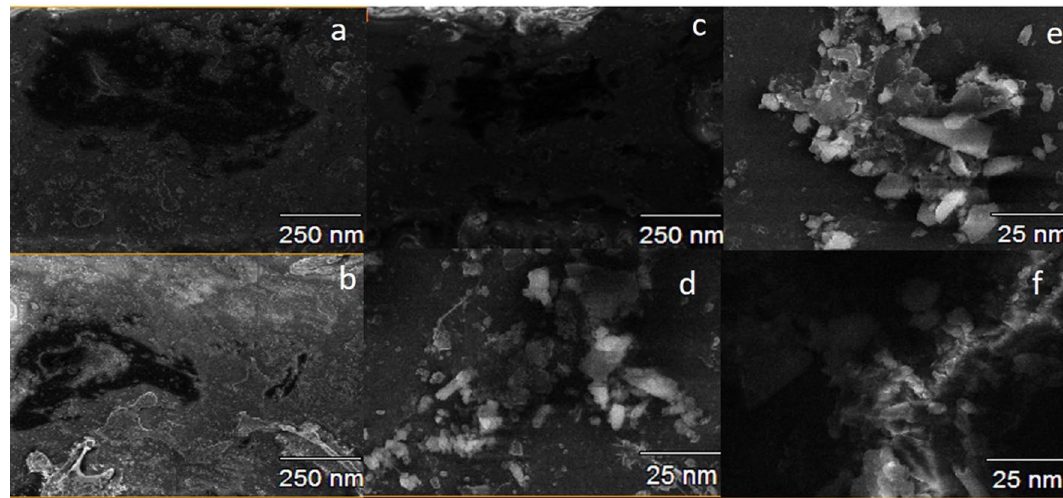
Figure 10. SEM (10,000×) analysis of biopolymer morphology in the bioactivity test: ( a ) G1 before immersion in simulated body fluid (SBF); ( b ) G1 after 14 days of immersion in SBF; ( c ) G2 before immersion in SBF; ( d ) G2 after 14 days of immersion in SBF; ( e ) G3 before immersion in SBF; and ( f ) G3 after 14 days of immersion in